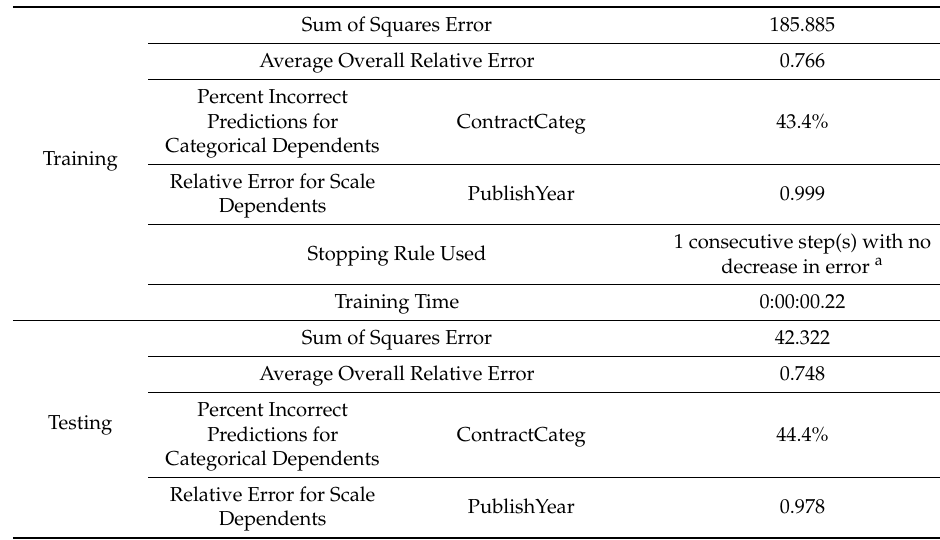
Table 3. ANN model